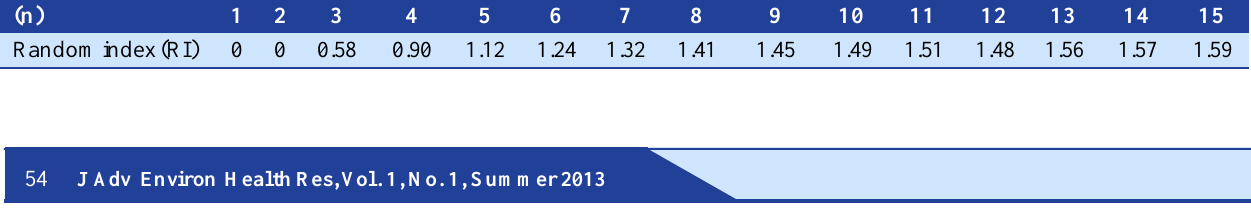
Table 1. Average ratio of inconsistency for corresponding matrix